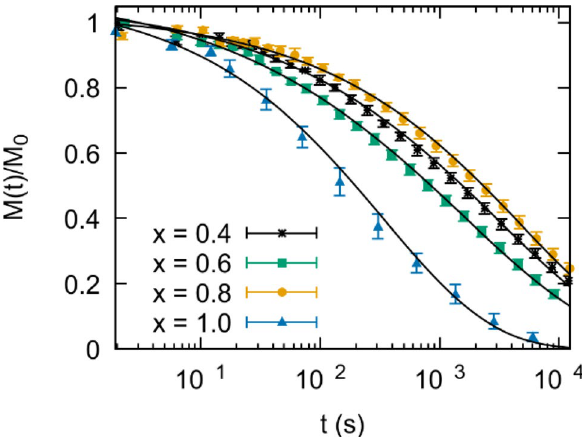
7200 s. Black lines =